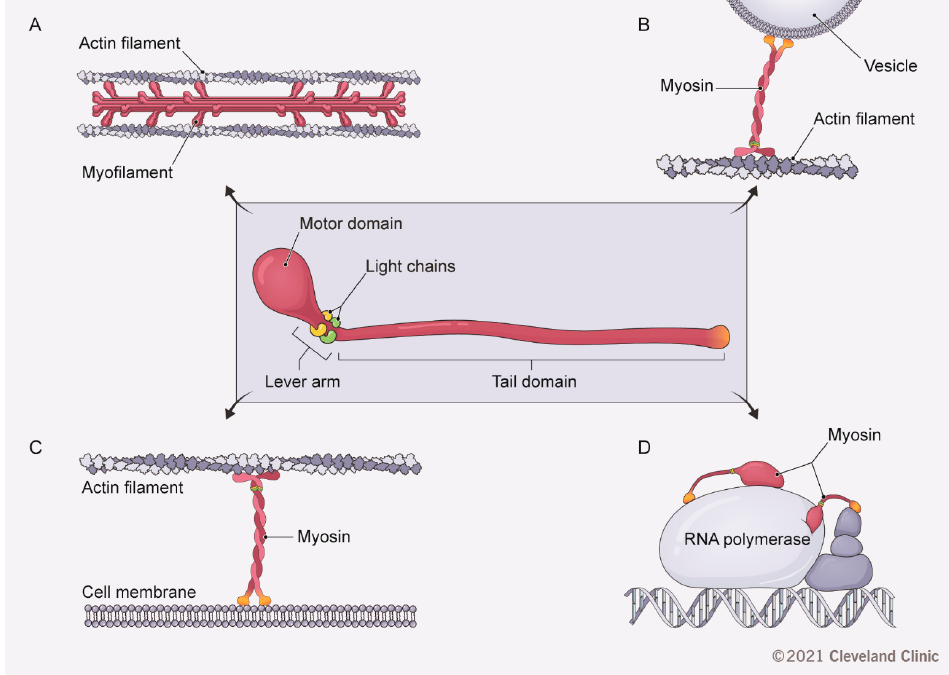
Figure 1. Molecular organization and cellular functions of myosin motors. The diagram illustrates a common domain structure of different conventional and unconventional myosins and their most characterized cellular activities in regulat- ing actin filament sliding/contractility ( A ), vesicle trafficking along actin filaments ( B ), tethering actin filaments to cellular membranes ( C ) and assembly of nuclear transcriptional complexes ( D ). Figure 1 by Brandon Stelter, BFA. Reprinted with the permission of the Cleveland Clinic Center for Medical Art & Photography © 2021. All Rights Reserved.